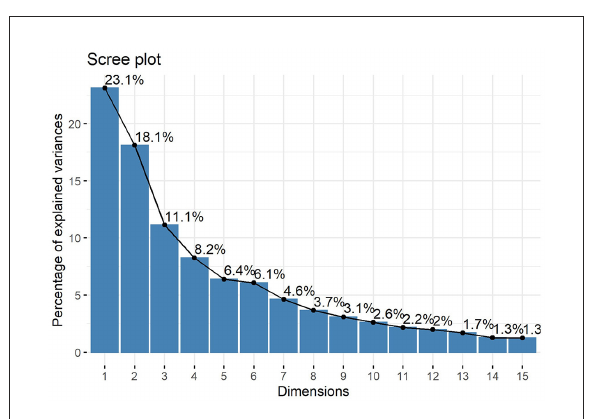
FIGURE4 Scree plot. The values indicate the percentage of variance and show that the cumulative percentage of the variance of the first 12 PCs reached